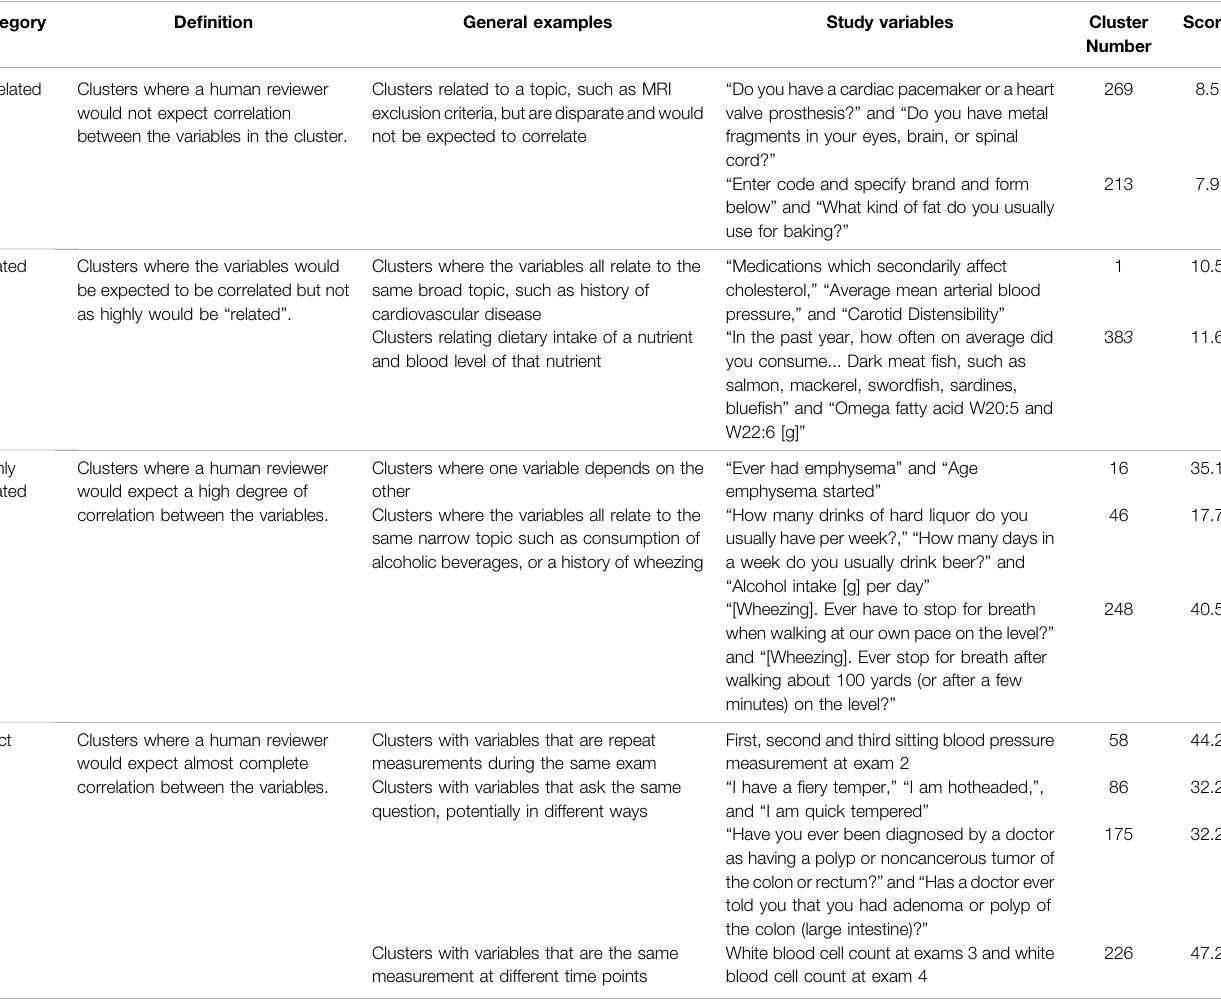
TABLE 1 | Examples of human and programmatic evaluation of variable clusters. The table includes the relatedness category from manual review (Category), working de fi nition of the category used by reviewers (De fi nition), examples of types of relationships in the category (General Examples), examples of ARIC variables that fi t each relationship type (Study Variables), a cluster identi fi er (Cluster Number), and calculated relatedness score from the NLP analysis (Score). The scoring process is described in further detail in the methods section. Examples were selected to demonstrate different types of variable relationships that exist among ARIC variables and the associated relatedness category. See Supplemental Table S1 for all